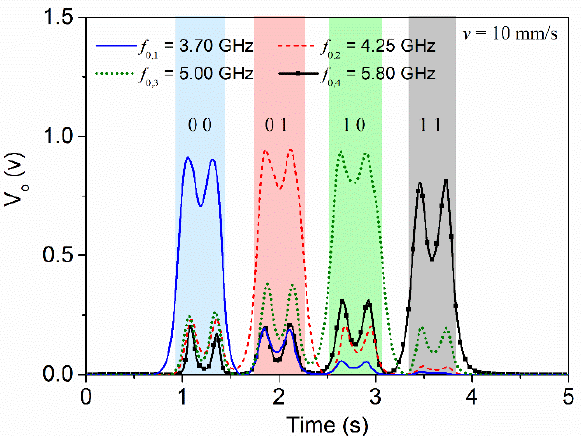
Figure 9. Photograph of the fabricated reader and encoder. Reprinted with permission from [65].